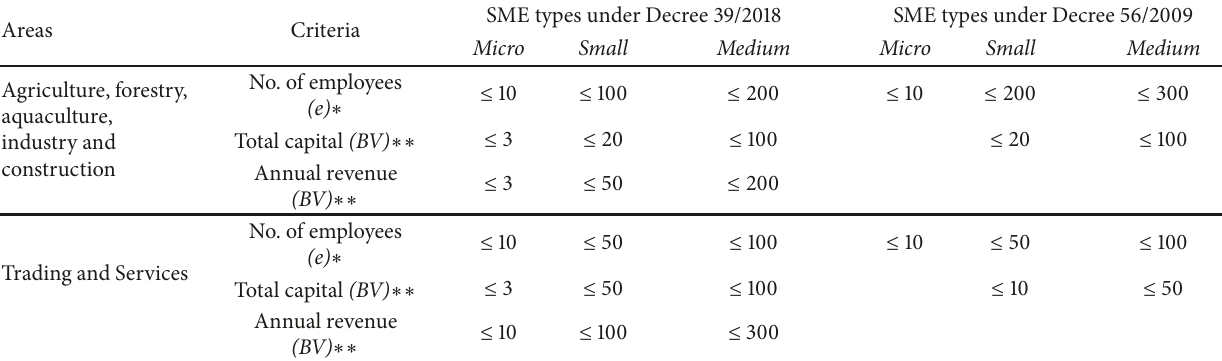
Table 1: Criteria in identifying types of SMEs in